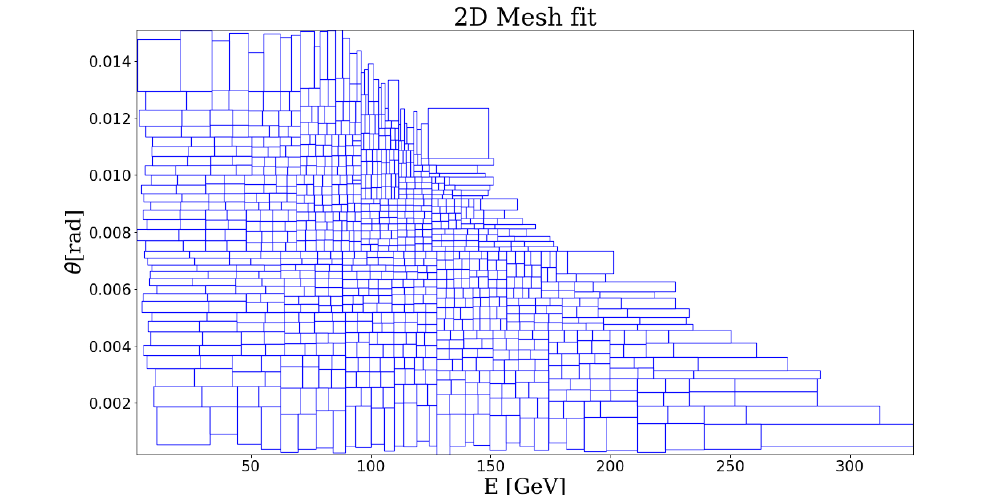
Figure 4. Result of the (cid:12)tting procedure. The area of the cells in the mesh is proportional to the number of events in the cells.